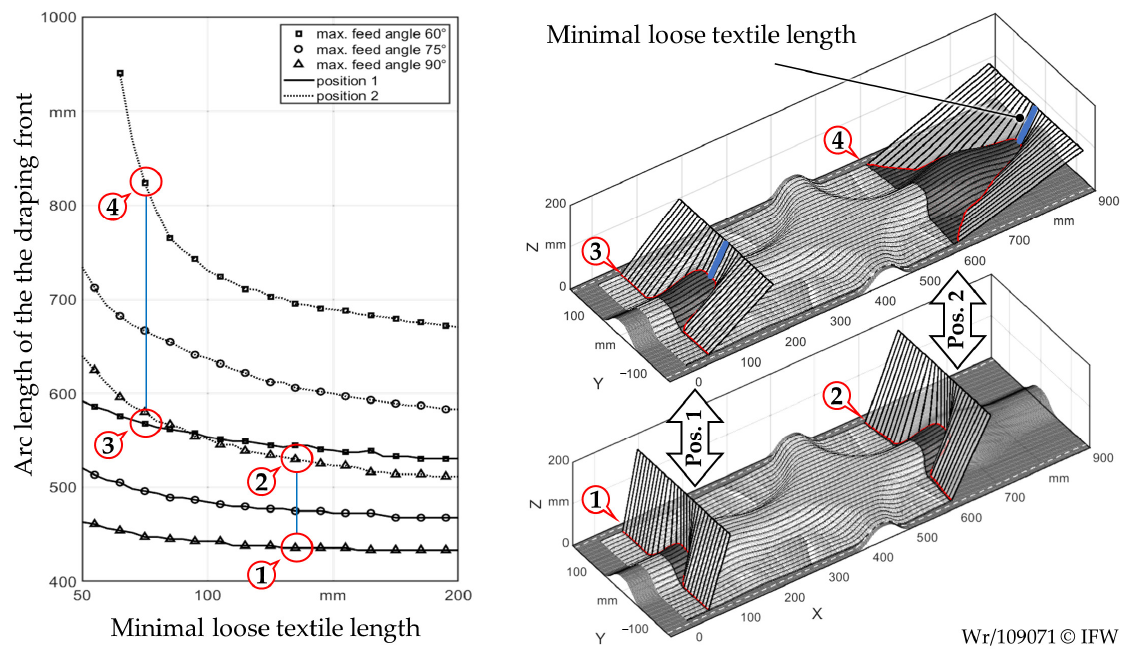
Figure 6. Dependency of the draping front on the feeding angle and the loose textile length at different positions during layup.